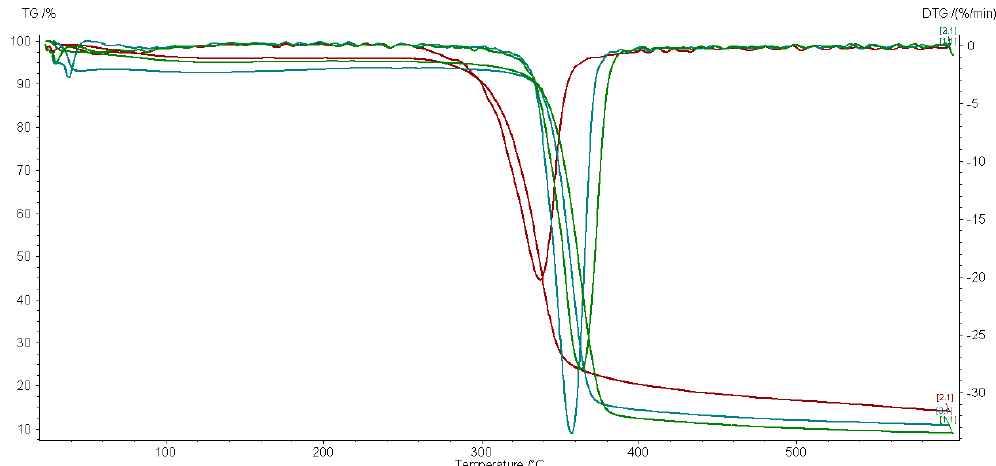
Figure 3. TG/DTG analysis of cotton impregnated with Ag/C (green lines), Ag/PVP (red lines), and ZnO/PVP (blue lines) and irradiated at 5 kGy in a wet state.